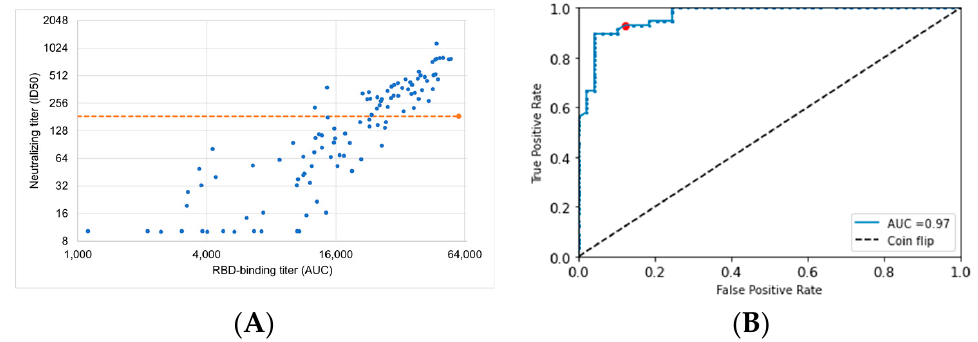
Figure 6. ( A ). Scatter plot demonstrating correlation between RBD-binding titer and neutralizing titer. The red horizontal line represents the threshold for 90% protection from WT mild disease. ( B ) . ROC analysis on the dataset in panel A demonstrates that ECLIA RBD binding can predict whether vaccine protection is sufficient to provide 90% protection from WT mild disease. Red point represents example threshold achieving 93% sensitivity and 88% speci fi city.